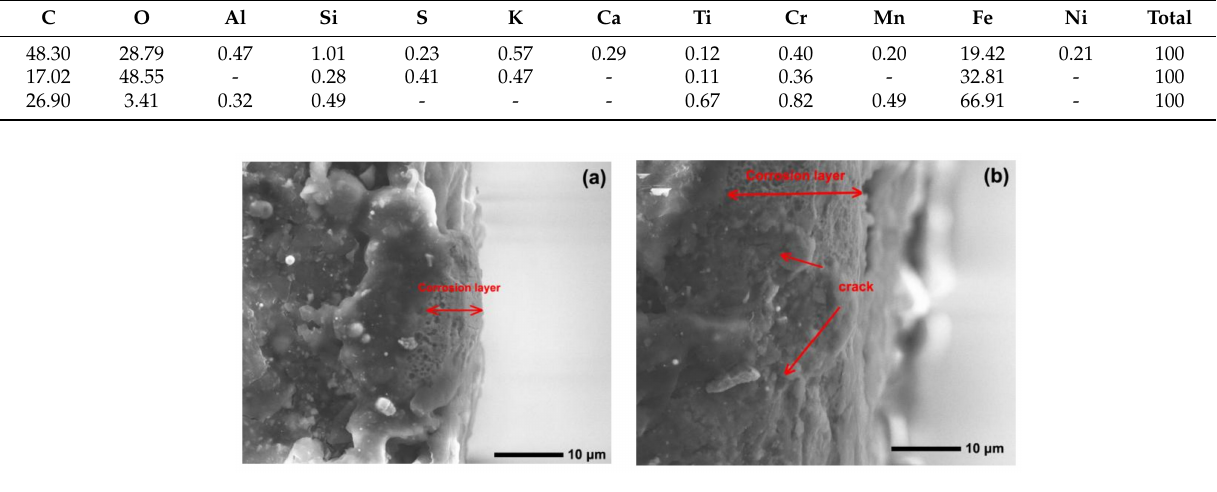
Figure 17. Cross-section SEM of ZM4-13 under coal gangue percentage of 50% and pH values of simulated mine water of 3.5: corrosive zone ( a ), worn and corrosive zone ( b